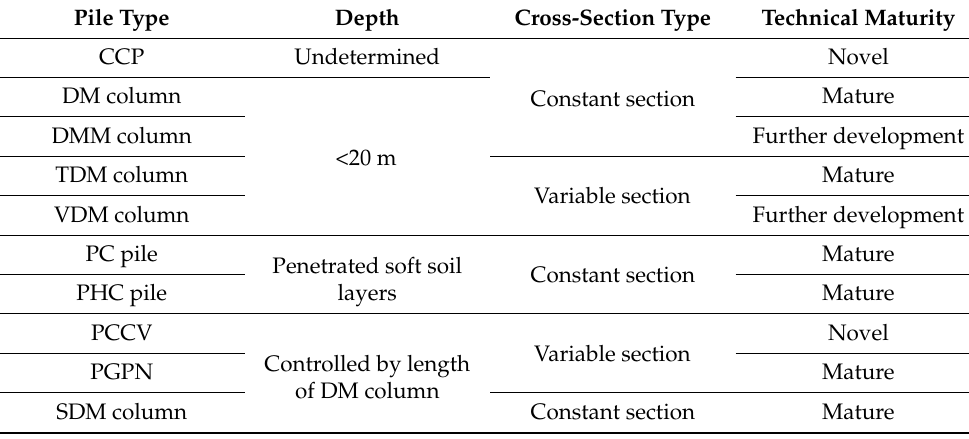
Table 2. The characteristics of various e ffi cient and low-carbon pile technologies.